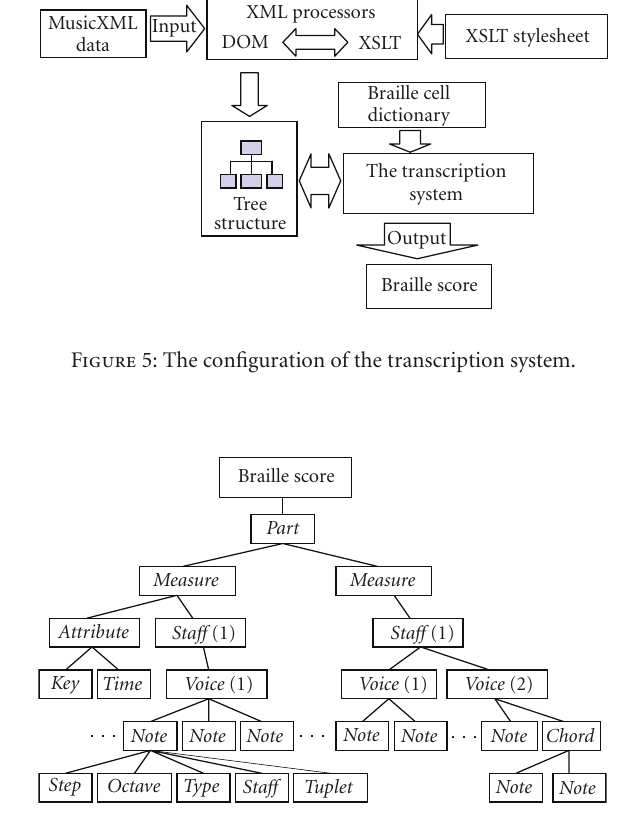
Figure 6: A sample tree structure of elements in Braille music no-